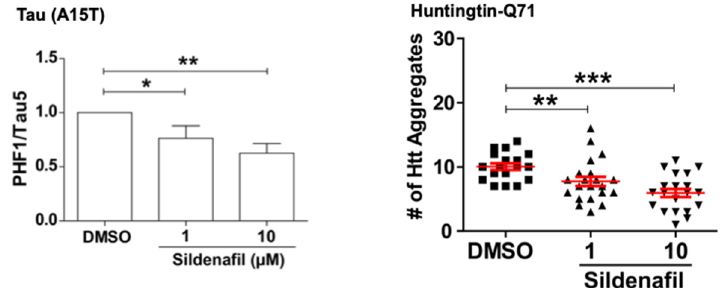
Figure 8. Raising cGMP levels promotes the clearance of mutant proteins in zebrafish models of a tauopathy and Huntington’s disease. (Left Panel) Zebrafish larvae expressing the tauopathy-associated A15T mutation in neurons were treated with sildenafil for 5 days. Their content of the hyperphosphorylated tau, expressed as a fraction of the total tau, was decreased, indicating selective degradation of the disease-associated species. (Right Panel) In zebrafish larvae expressing huntingtin with a 71-glutamine repeat in the retinal photoreceptor cells, sildenafil treatment for 5 days also reduced the number of huntingtin aggregates (adapted from [16]). (* denotes p < 0.05, ** p < 0.01, and *** p < 0.001).